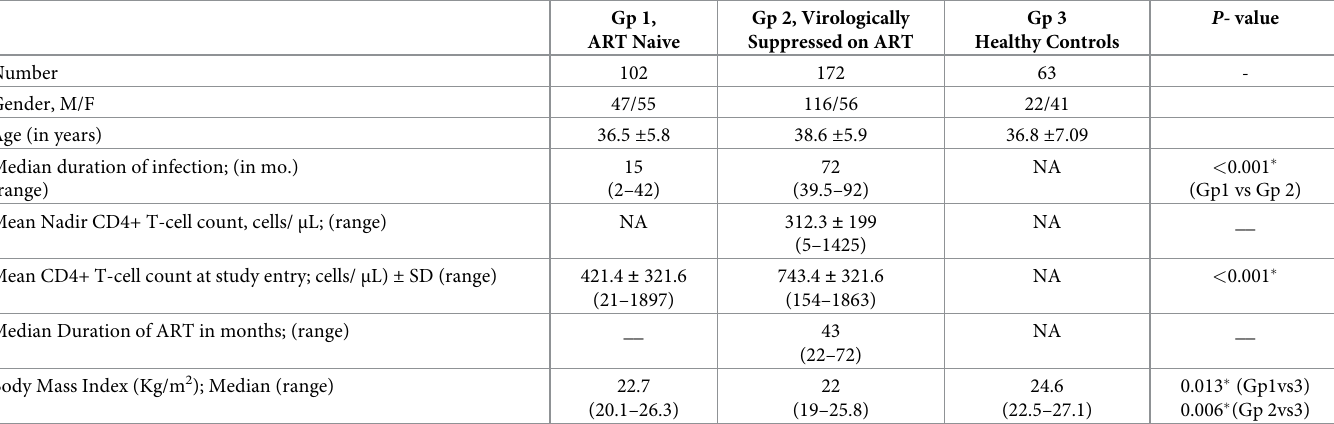
Table 1. Characteristics of the study